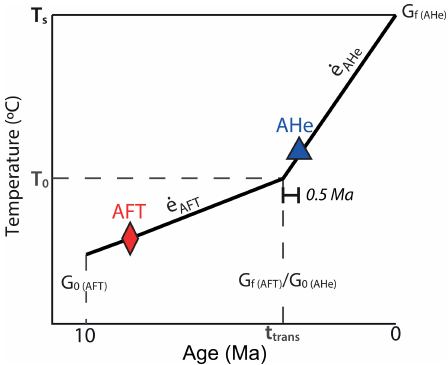
Figure 4. Schematic of paired-age erosion rate analysis, illustrat- ing the theoretical temperature path through time for a sample with paired AFT and AHe cooling ages, given the thermal parameters described in the text; ˙e represents the erosion rate for each cooling